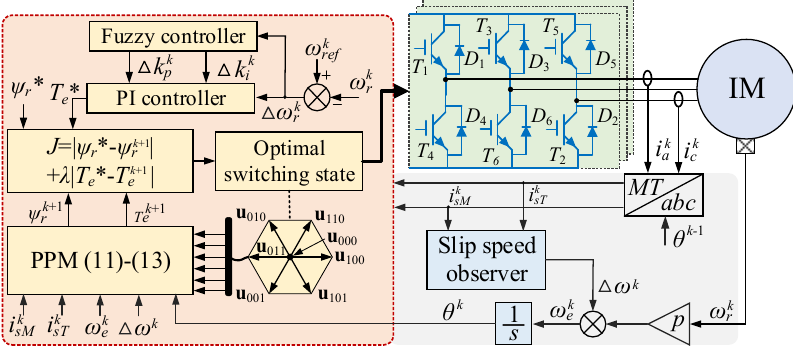
Figure 4. Block diagram of proposed fuzzy adaptive PI controller-based FCS-MPTC.